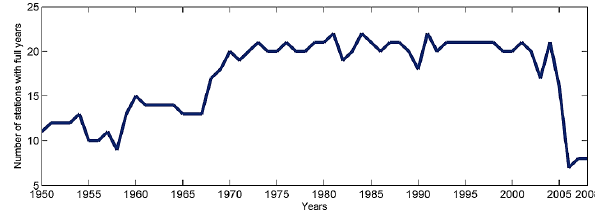
Fig. 3. Number of stations with full years (less than 5% missing data) between 1950 and